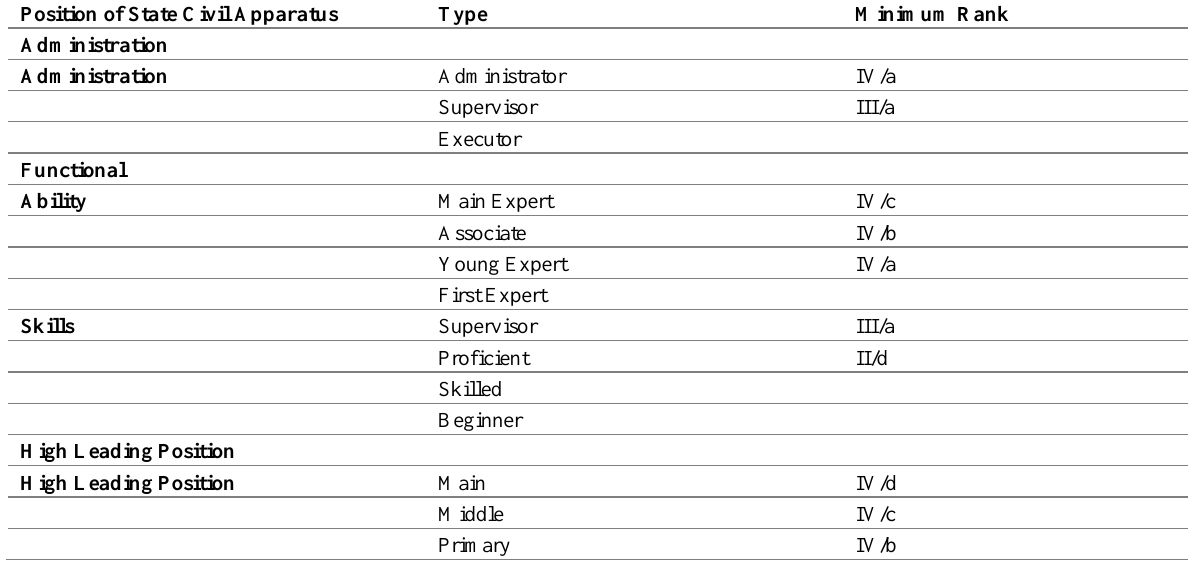
Table 2 : Position of State Civil